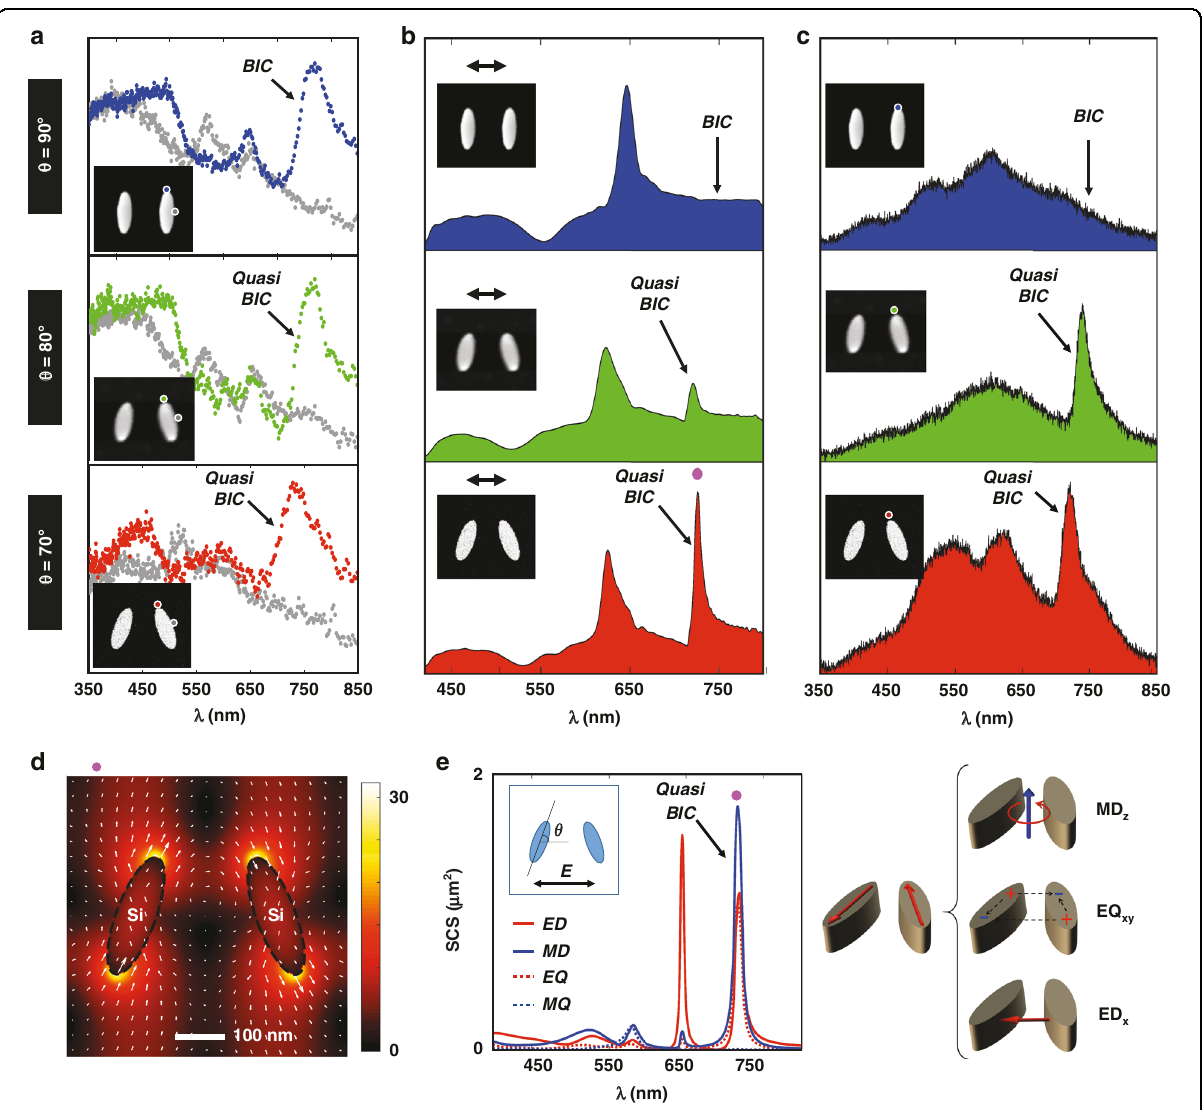
Fig. 3 Evolution of CL and EELS spectra for nanoantenna arrays with different tilt angles. a Measured EELS spectra, b re fl ectance spectra under x -polarized incidence condition, and c CL spectra from the nanoantenna array with different tilt angle θ of 90°, 80°, and 70°. d Spatial distribution of the electric fi eld | E | at the quasi-BIC resonance at ~720 nm for the nanoantenna array with a tilt angle θ of 70°. The arrows denote the electric fi eld direction, the length of the arrows being proportional to the amplitude. e Multipolar decomposition of the scattering cross-section (SCS) and corresponding schematics of the multipoles excited at the quasi-BIC